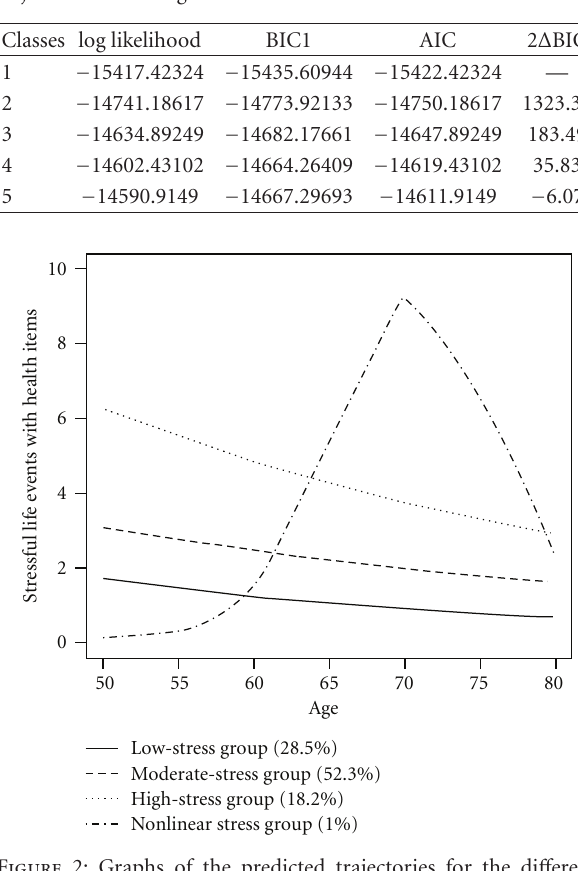
Table 1: Determining the number of classes for stressful life event trajectories including health items.